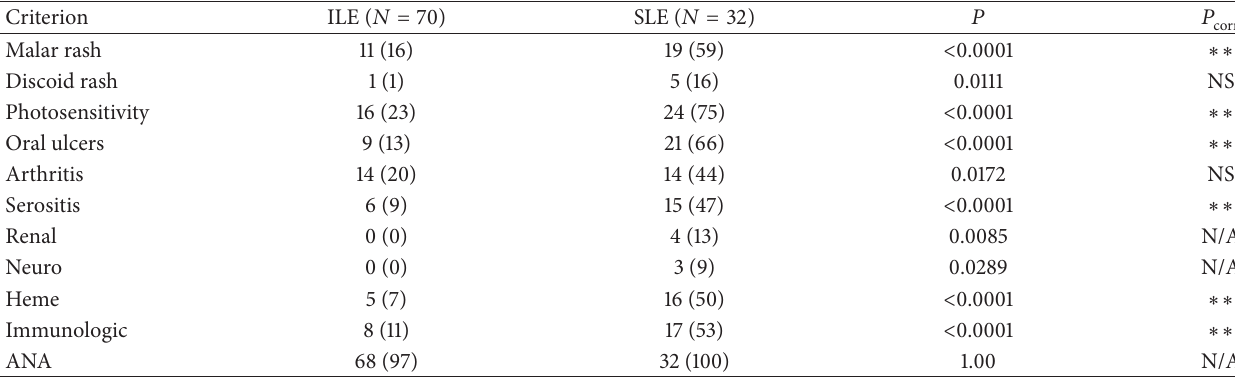
Table 2: ACR classification criteria in ILE and SLE patients.